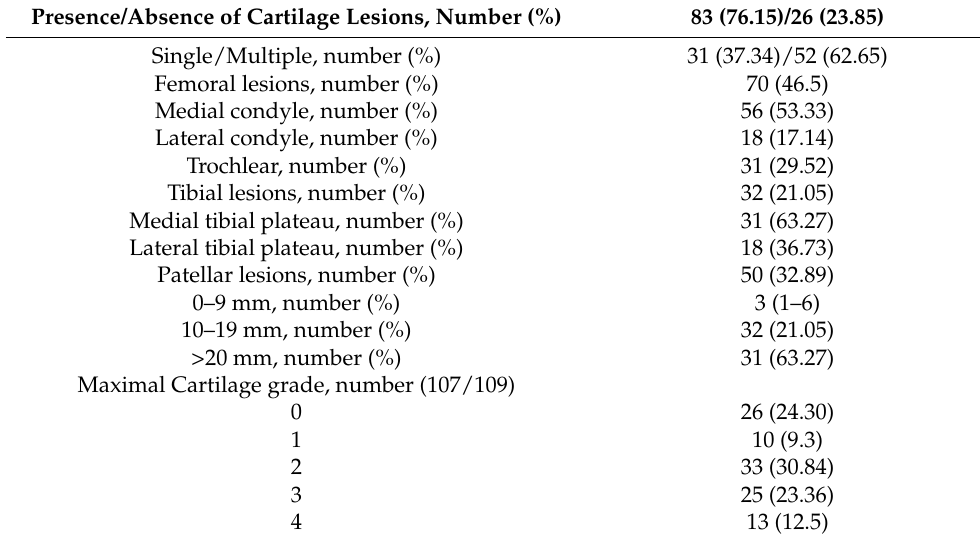
Table 3. Cartilage lesion features (N = 109).